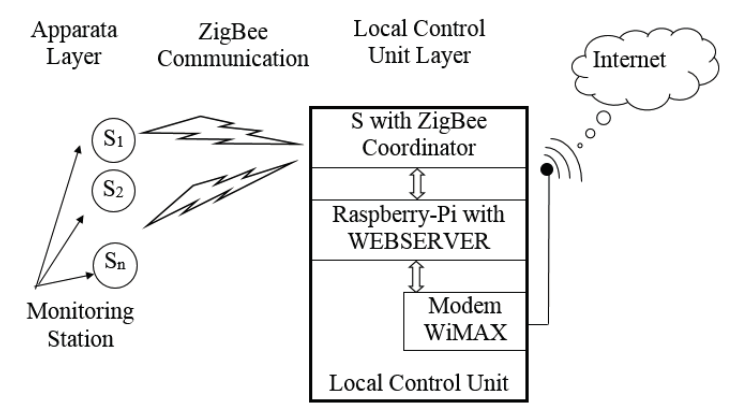
Figure 1. Block scheme of the system